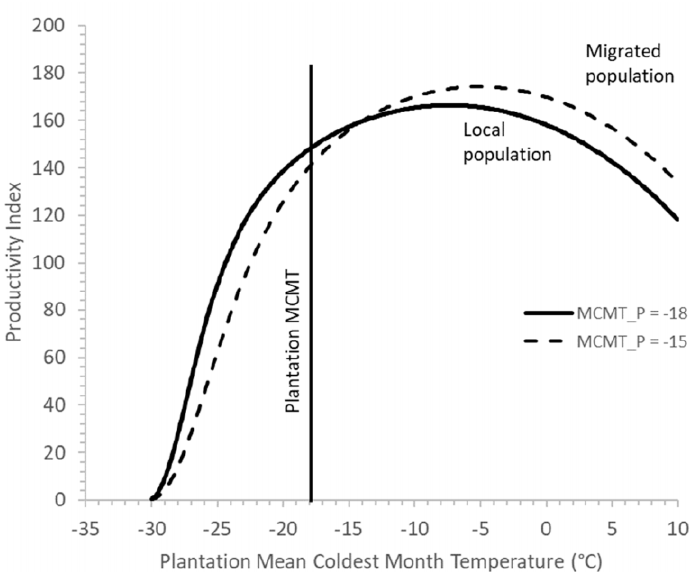
Figure 4. Modelled response function showing predicted relative productivity trajectory of “local” (solid line) and migrated (broken line) populations of Picea glauca × engelmannii hybrid complex (MCMT_P = − 18 and − 15 ◦ C, respectively) when planted at the climate origin of the local population, represented by the vertical